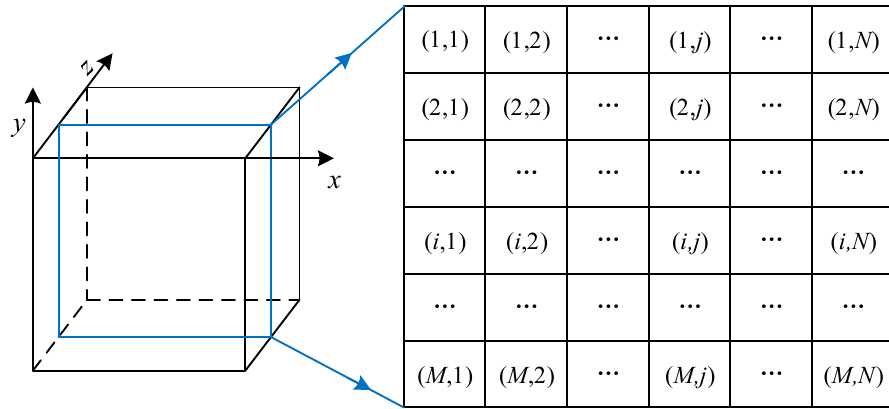
Figure 4. The finite difference method of cross-flow and counter-flow HST.